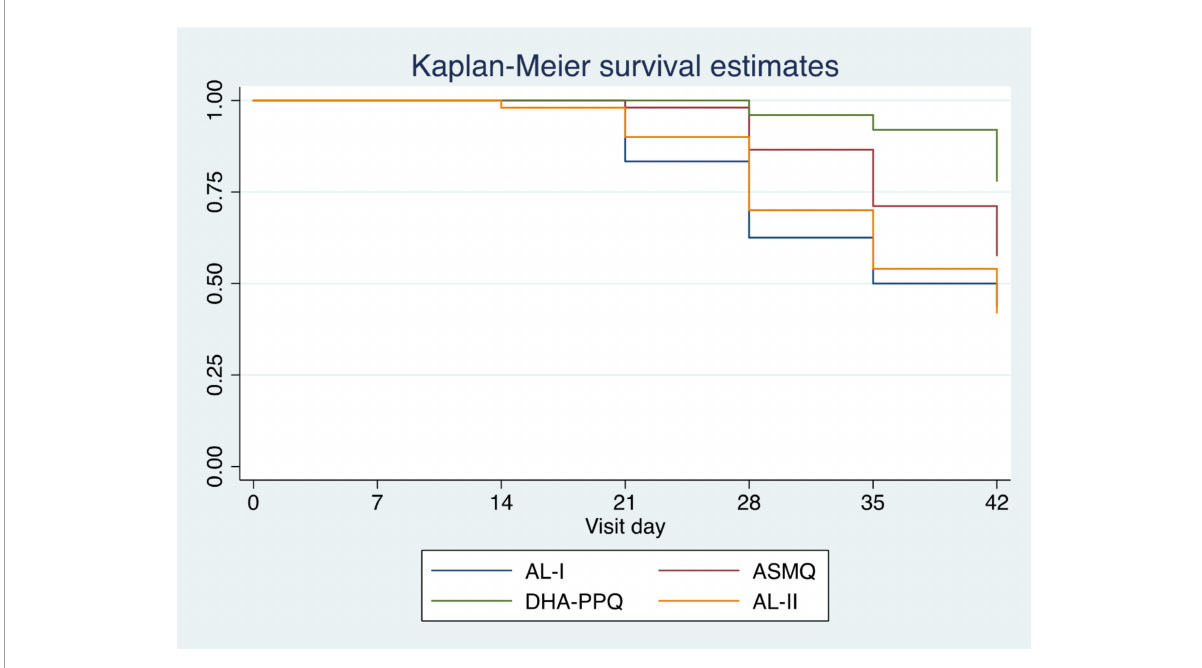
FIGURE1 Kaplan-Meier survival estimate for time to malaria infection following ACT treatment. Survival curves are shown for Cohort 1, AL subjects (blue), ASMQ subjects (red) and Cohort II AL subjects (orange), and DHA-PPQ subjects (purple) as a function of days post-treatment.